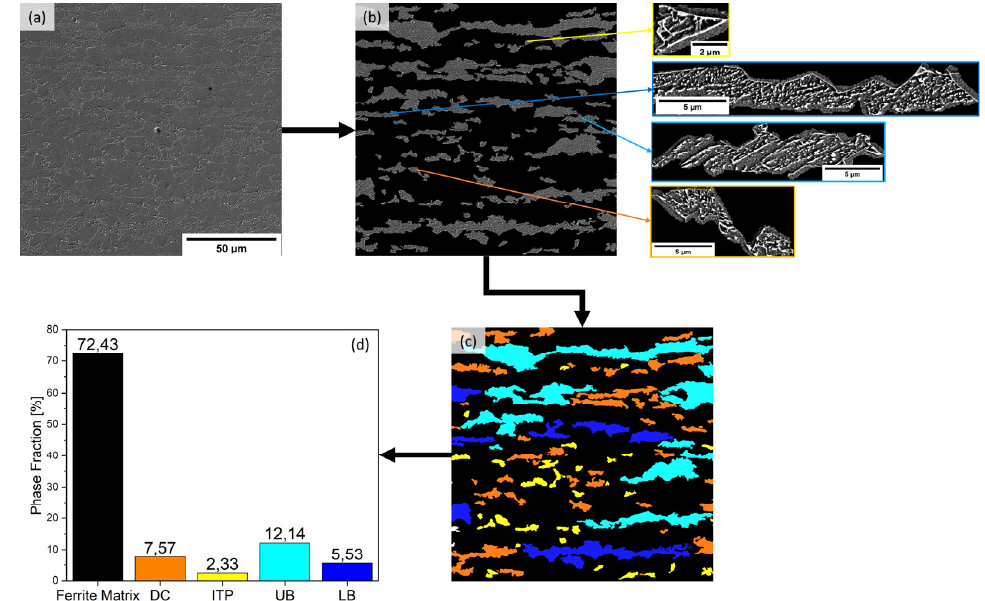
Figure 1. Illustration of classification task: ( a ) SEM micrograph. ( b ) Extraction of carbon-rich second phase objects: several classes can be present simultaneously. ( c ) Microstructure classification based on extracted features. Objects are colored according to the classification result. ( d ) Determination of phase fractions according to the classification result (DC: debris of cementite, ITP: incomplete transformation product, UB: upper bainite, LB: lower bainite).